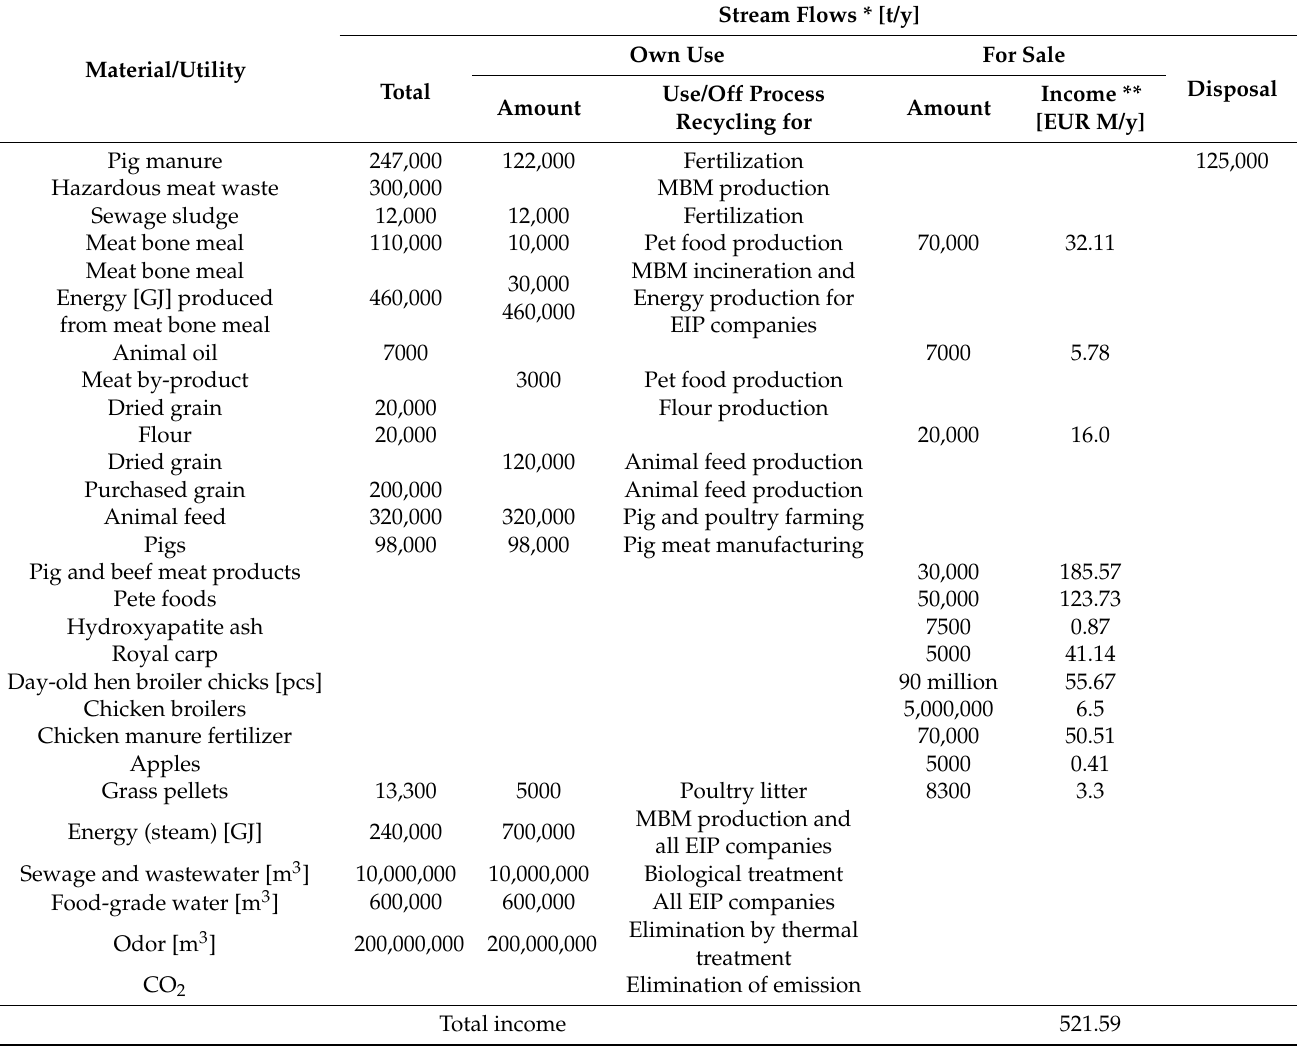
Table 1 present summarized data in terms of material and energy stream flows ex- change per year among the ´Smiłowo EIP included data on the types of products manufac- tured by companies of EIP ´Smiłowo, their production volume on an annual basis, indicated amounts of materials used as raw material for own use, disposal and sale, as well as the amount of energy generated and waste processed. EIP ´Smiłowo utilizes 300,000 t/y meat waste into the production of 110,000 t/y MBM of biofuel, uses 120,000 t of pig manure as a substitute of artificial fertilizers, produces 460,000 GJ energy by combustion MBM biofuel. Table 1. Material and utility stream flows exchanged annually among the ´Smiłowo